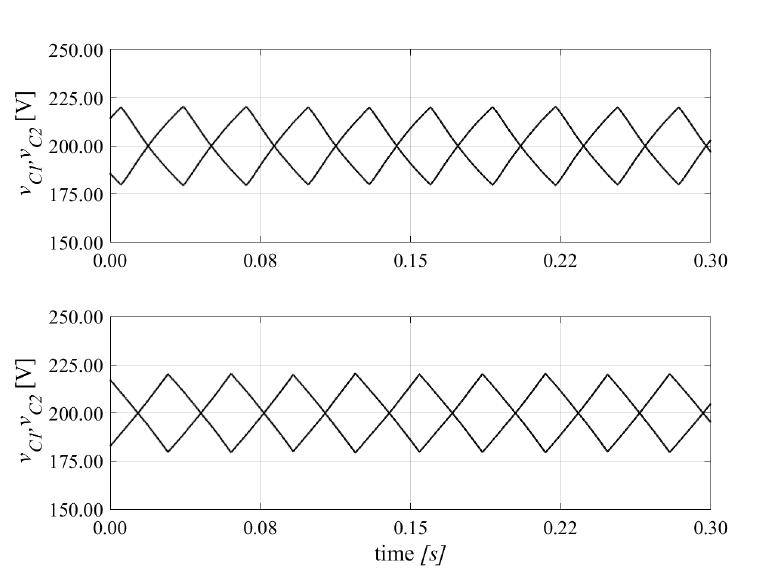
Figure 6. Numerical result: capacitors voltages for the traditional SVM (upper trace) and proposed one (lower trace), when m = 0.27, v ∗